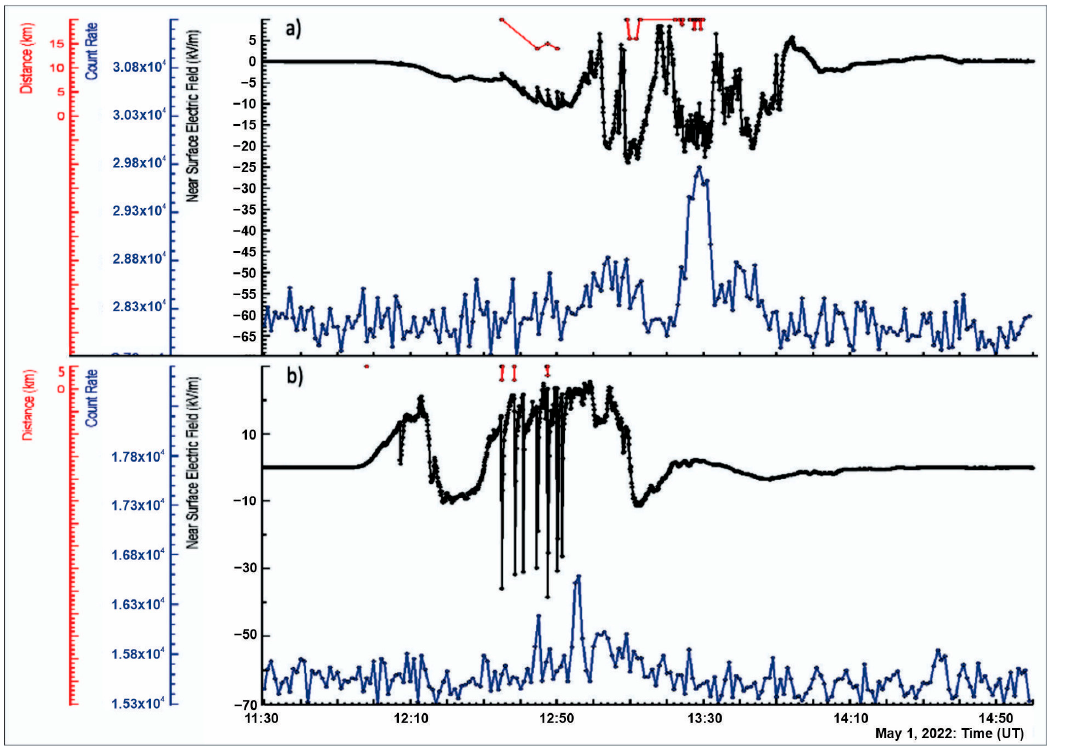
Figure 8. Disturbances of the NSEF (black); 1-minute time series of count rates of 5 cm thick and 1 m 2 area plastic scintillators (blue); and distances to lightning flashes (red) measured on Aragats ( a ) and in Nor Amberd ( b ). Atmosphere 2023 , 14 , x FOR PEER REVIEW